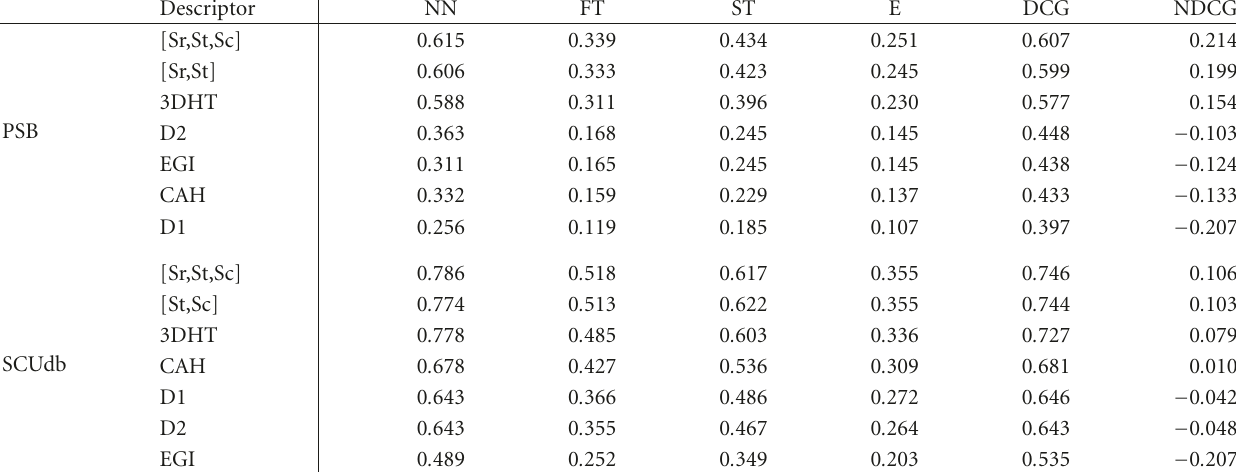
Table 9: General performances of histogram and density-based